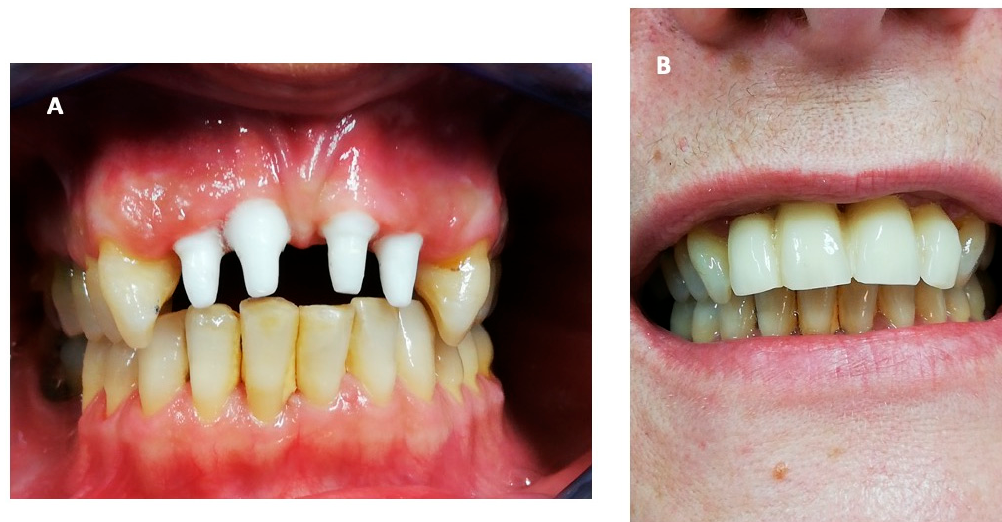
Figure 5. Pictures obtained 14 months after the operation: ( A ) healthy periodontal tissues and integrated implants and ( B ) the final aesthetic effect with zirconia dental crowns.